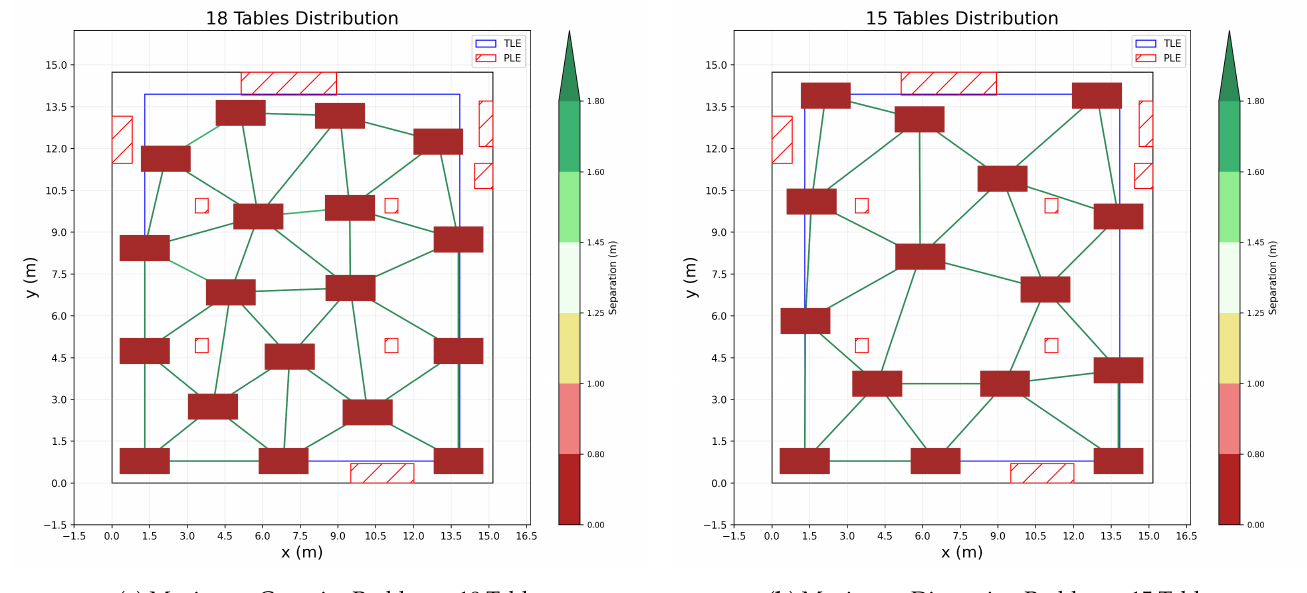
Figure 7. Obtained Table distributions by the proposed MA algorithm. Both maximum capacity ( a ) and maximum dispersion configurations ( b ) proved the flexibility of the MA optimisation for multiple table